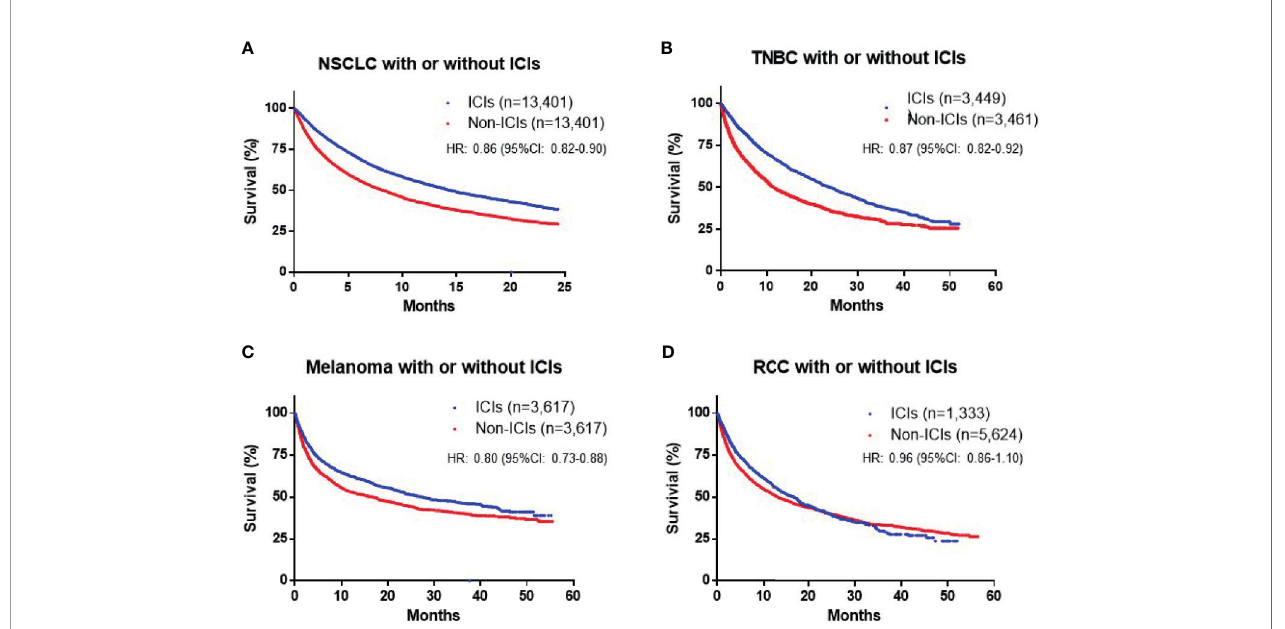
FIGURE 2 | Overallsurvival(OS) inpatients with different cancer subtypes [ (A) nonsmall-celllungcancer (NSCLC), (B) triple-negative breast cancer (TNBC), (C) melanoma and (D) renal cellcarcinoma (RCC)], with and without immune checkpoint inhibitor (ICI)